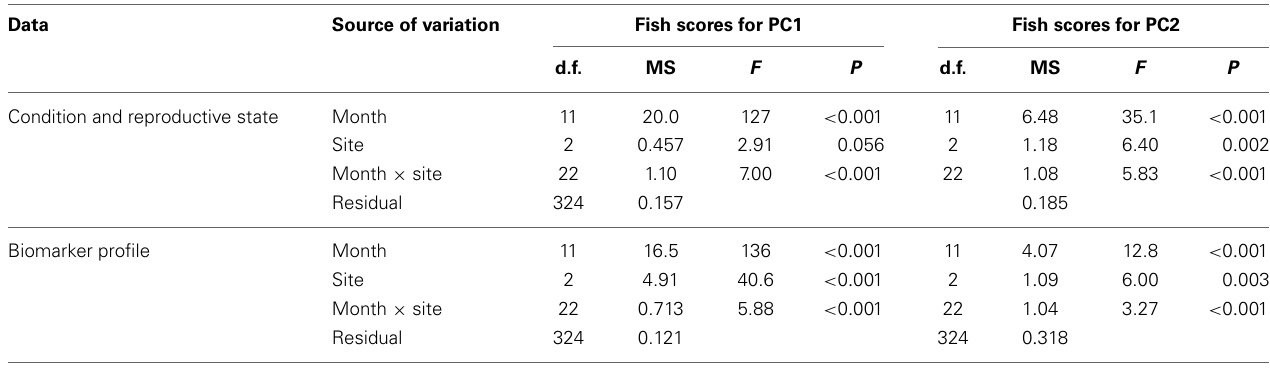
Table 1 | Summary of Two-Way ANOVA on the fish scores (principal components 1 and 2), showing the degrees of freedom (d.f.), variance (MS), F- test and corresponding P-